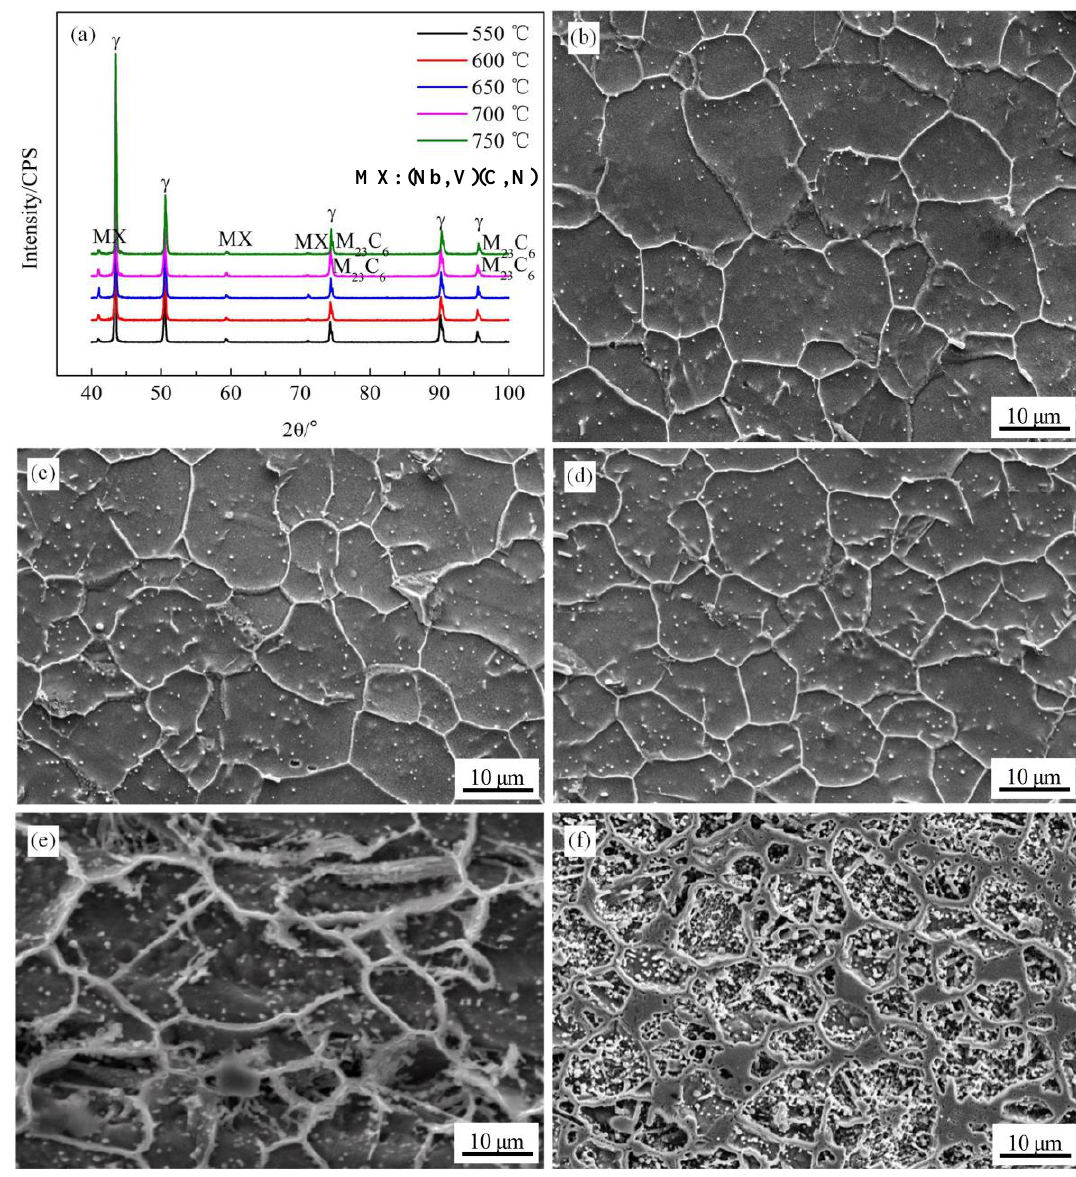
Figure 4. XRD and SEM of the specimens aged at different temperature for 2 h. ( a ) XRD analysis, ( b ) 550 °C, ( c ) 600 °C, ( d ) 650 °C, ( e ) 700 °C, ( f ) 750 °C.